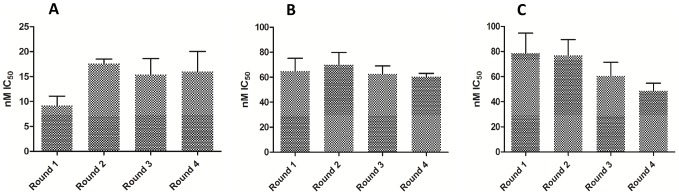
Reference compound activity against T.b. brucei in the primary screening campaign.Dose-response curves for the reference compounds pentamidine, puromycin and diminazene against T.b. brucei in the primary screening campaign. Means and standard deviations of replicate IC50 values were (A) pentamidine, 14.7±4.7 nM (B) puromycin, 61.86±6.8 nM and (C) diminazene, 65.4 nM±12.5 nM. Data is representative of 13 control plates each containing 3 replicates of the compounds in dose, with batches indicative of daily screens.